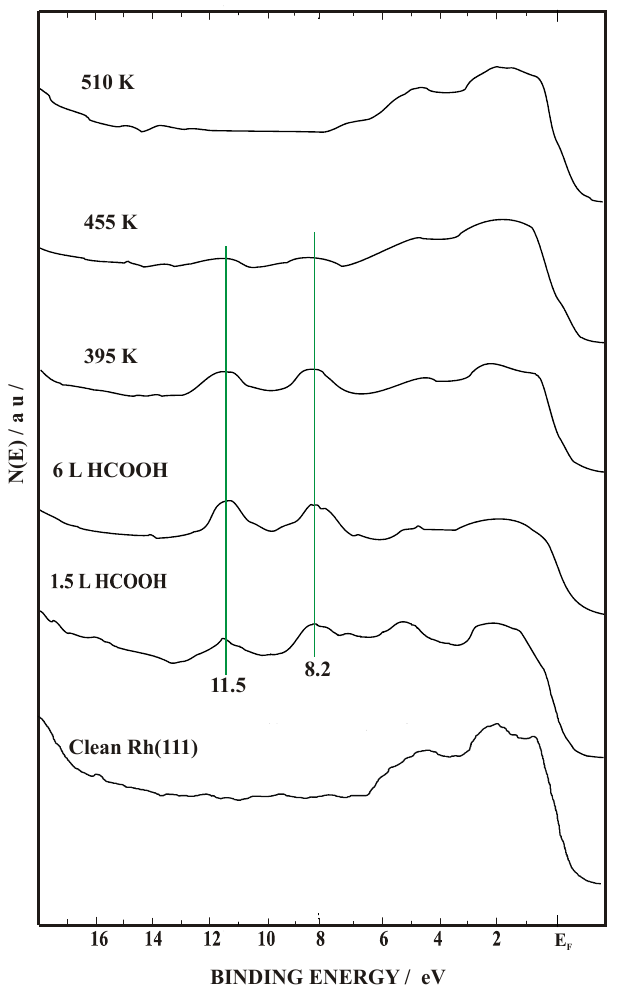
Figure 6. UP spectra after adsorption of FA on clean Rh(111) at 300 K and subsequent heat treatment. FA exposure was 12 L.